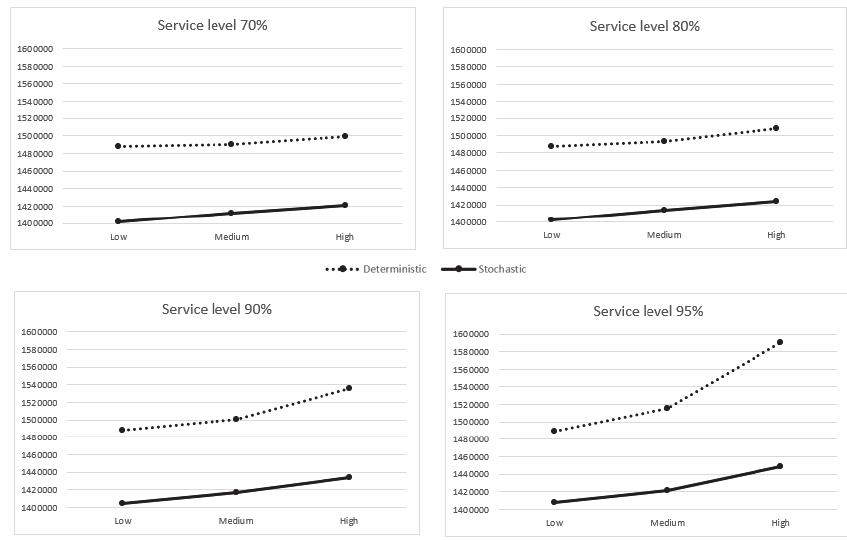
Fig. 7. Profile graphs of experiment